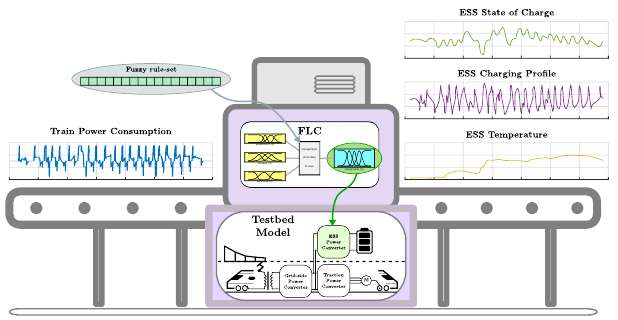
Figure 6. Illustration of the testbed: at each time instant, the train power consumption is used together with state of charge and temperature to generate a charging profile; then from the generated charging profile, the SoC and the ESS temperature are